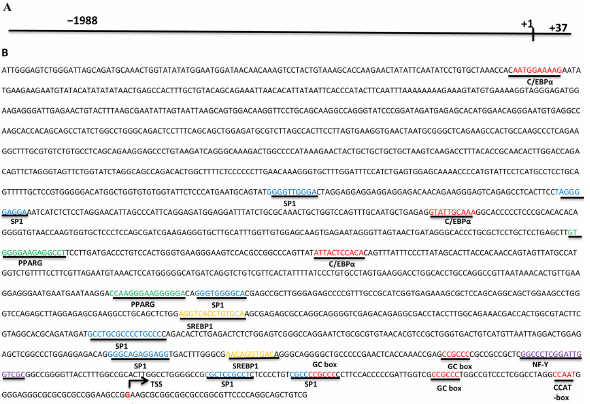
Figure 5. Sequence identification of the goat MCD promoter.( A ) Length of the goat MCD promoter sequence obtained by cloning. ( B ) Analysis of regulatory elements in the goat MCD promoter sequence.